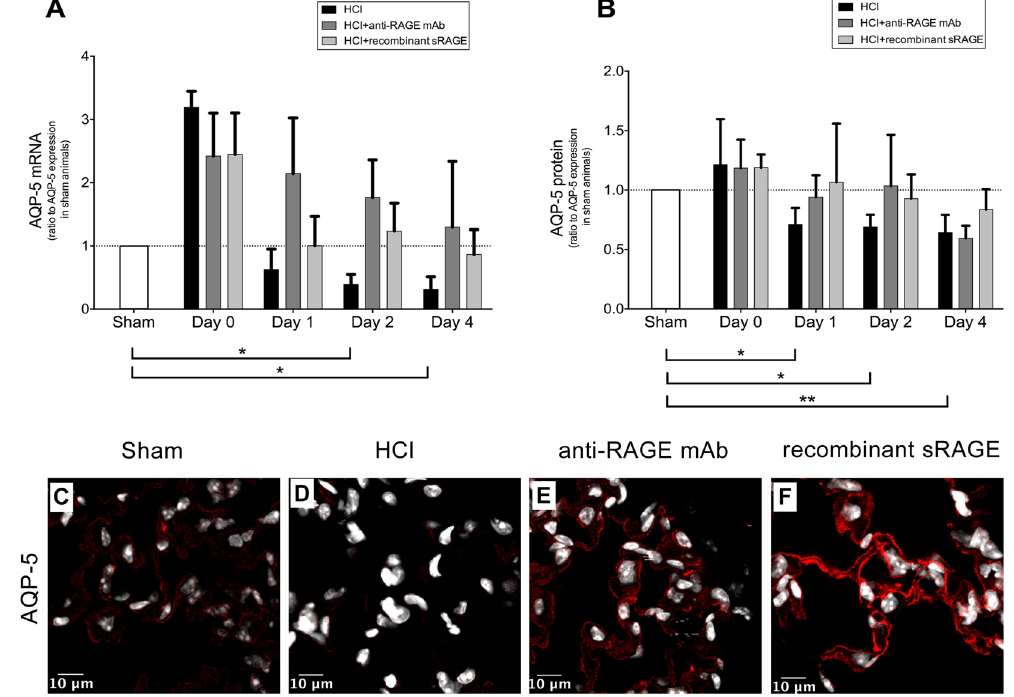
Figure 8. Treatment with both anti-RAGE monoclonal antibody (mAb) and recombinant sRAGE restore Aquaporin (AQP)-5 expression in mouse alveolar epithelial cells. Levels of AQP-5 ( A ) mRNA and ( B ) protein in acid-injured mice (HCl group), acid-injured mice treated with anti-RAGE monoclonal antibody (HCl + anti- RAGE mAb group) or with recombinant sRAGE (HCl + sRAGE group), and in uninjured, untreated mice (Sham group)(n = 4–6 for each time-point). Levels of AQP-5 proteins were measured in duplicate via ELISA. Threshold levels of mRNA expression ( ∆∆ Ct) were normalised to housekeeping genes. Protein and mRNA expression levels are expressed as ratios to those in sham animals. As no difference was observed between sham animals at all time points; the results from sham mice were mixed for analyses (left bar of the X-axis). Values are reported as means ± standard deviations. * P < 0.05; ** P < 10 − 2 versus sham controls RAGE inhibition restores alveolar membrane expression of AQP-5 in acid-injured mice. Representative photographs of immunohistochemistry on mouse lungs probed at day 1 for (C – F) AQP-5 protein. Nuclei were labeled with 4 ′ ,6-diamidino-2-phenylindole (DAPI). Control slices stained without primary antibodies were always negative (Supplement, Fig. S5). Original magnification × 40. Scale bar = 10 µ